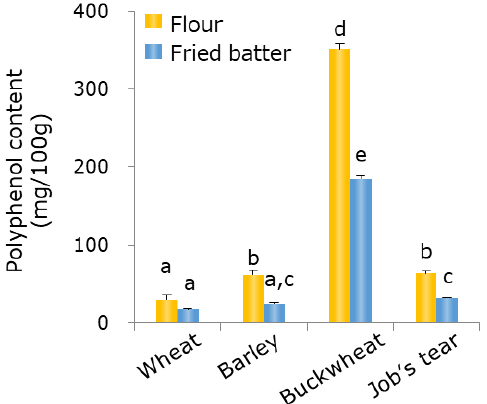
Figure 3. Polyphenol content in each of the flours examined in this study, measured using the Folin–Denis method. Each value represents the mean ± SD ( n = 3). Different letters a-e for flours and fried batter indicate a significant difference ( p < 0.05, Tukey test).